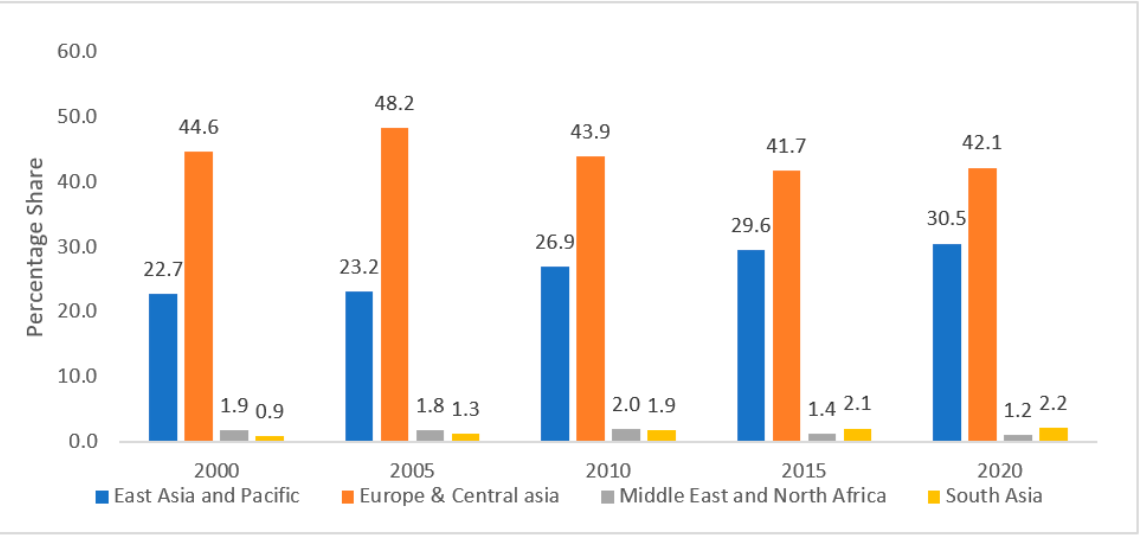
Figure 1. Percentage Share of Exports from BRI Economies. Source: World Bank Group, 2018.